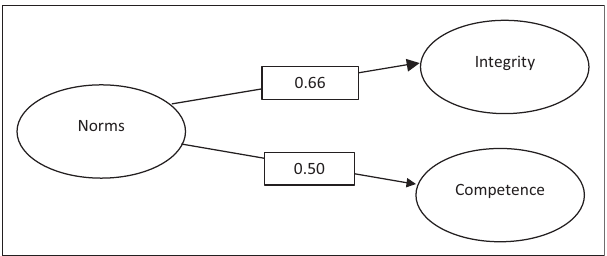
FIGURE 2: Structural equation model of the prediction of Trust in Teams Scale (Adams et al., 2008) by means of the norms factor of the Revised Thomson, Perry and Miller (2007) Collaboration